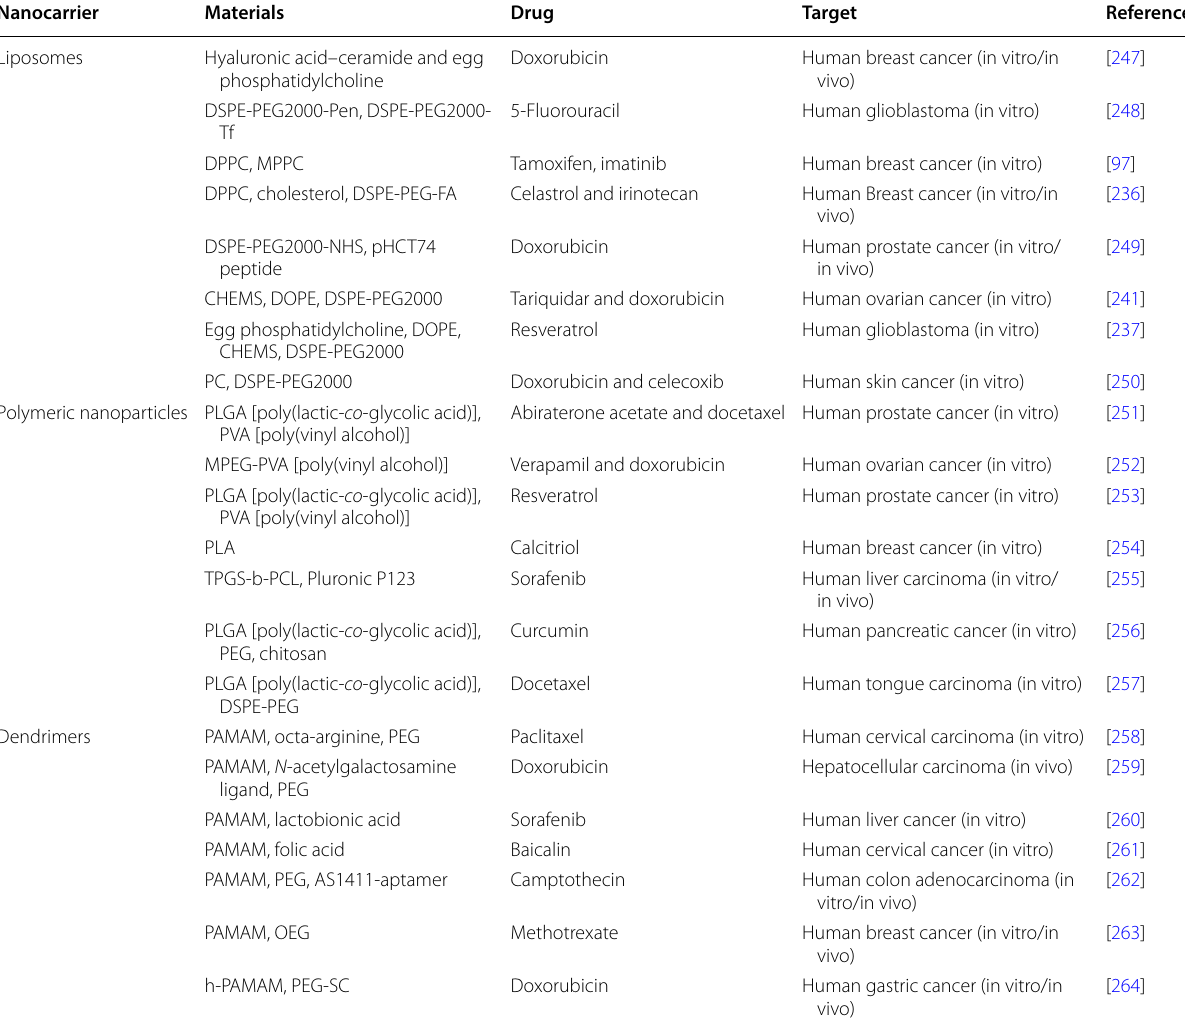
Table 3 Summary of different organic nanomaterials used as drug delivery carrier for anticancer drugs